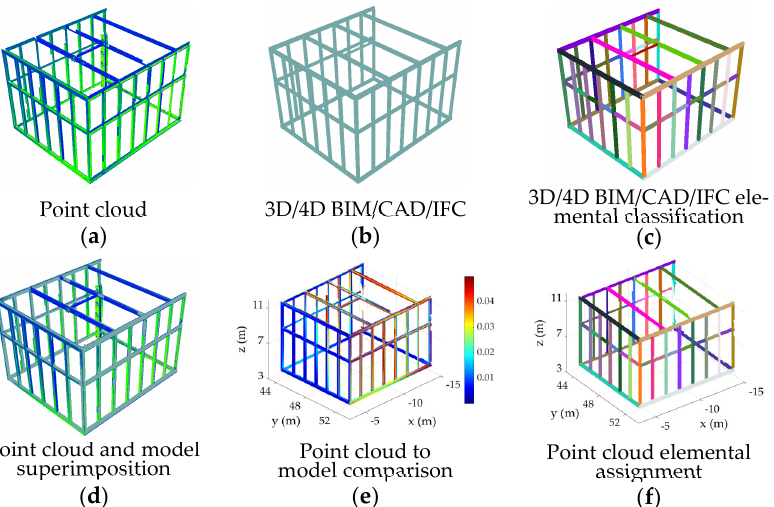
Figure 1. Typical framework for automatic assignment of points to the designed multi-dimensional (n-D) information model elements: ( a ) point cloud, ( b ) n-D information model, ( c ) elemental classification of the designed model, ( d ) superimposition of the point cloud and the model, ( e ) point-cloud-to-model comparison (in this case, the color represents the distance of the points to the closest element’s surface), and ( f ) result of assignment of the point cloud to the corresponding elements.